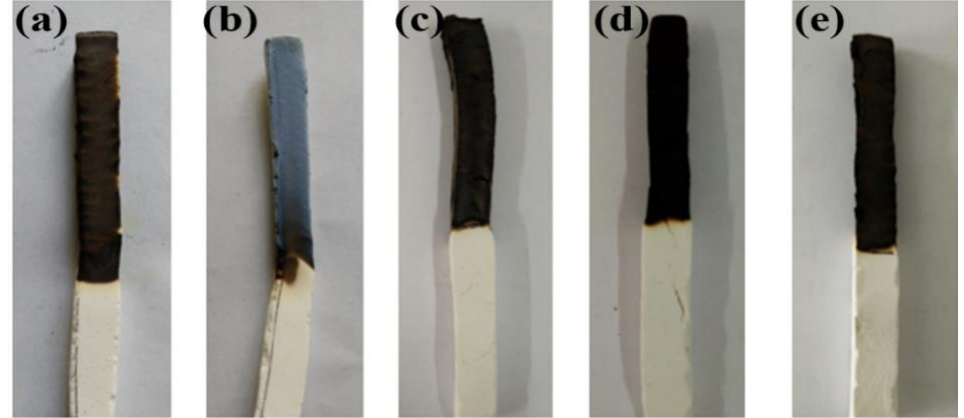
Figure 4. Digital photographs of the different PAM composite aerogels after LOI test. ( a ) PAM, ( b ) PAM/Ms, ( c ) PAM/MsCa, ( d ) PAM/K, ( e ) PAM/KCa. Table 3. LOI and UL-94 rating of the different PAM composite aerogels.